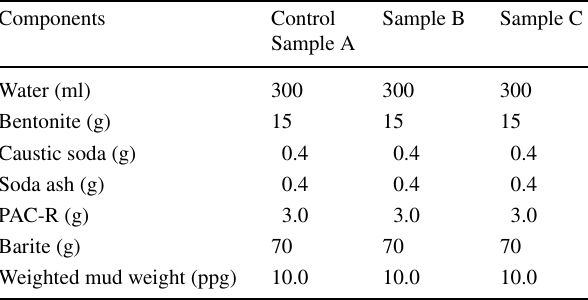
Fig. 4 Diagram of Soxhlet